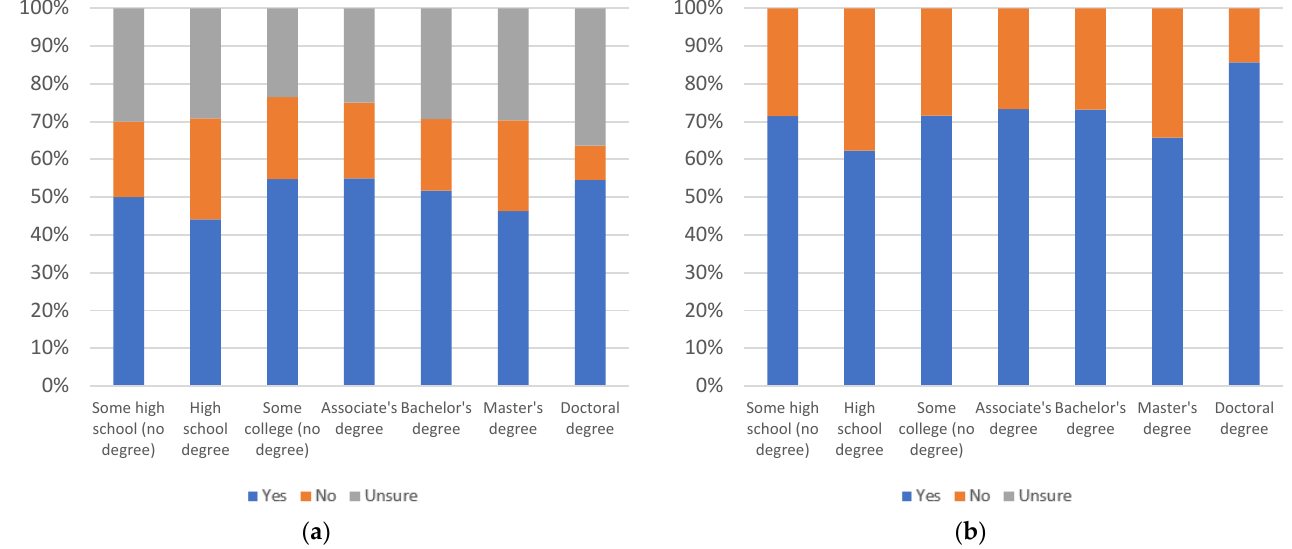
Figure 79. Label others’ use, by education level: ( a ) with uncertain respondents (left) and ( b ) without uncertain respondents (right).